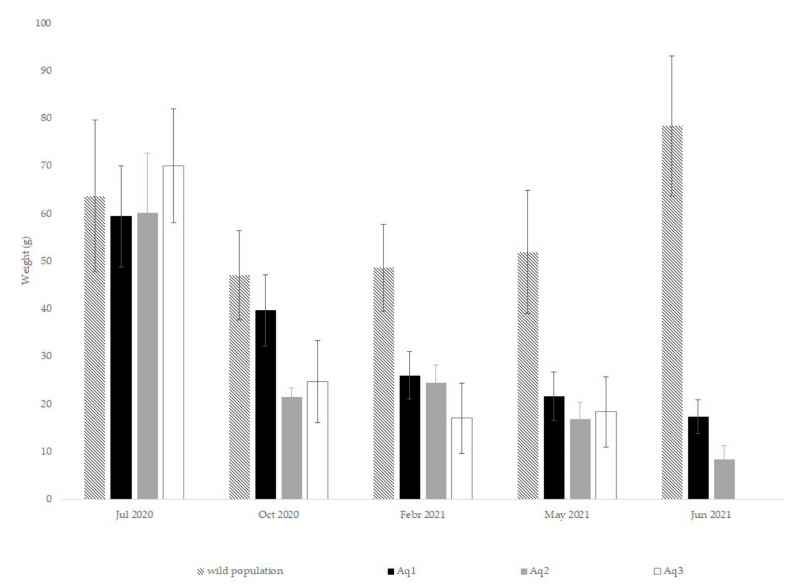
Figure 5. Weight of holothurians in IMTA farms (Aq1: Epidauros, Ag2: Evoikos, Aq3: Rhodos) and in natural populations for four seasons, from July 2020 to July 2021. Data are expressed as the mean ± standard deviation (n = 15